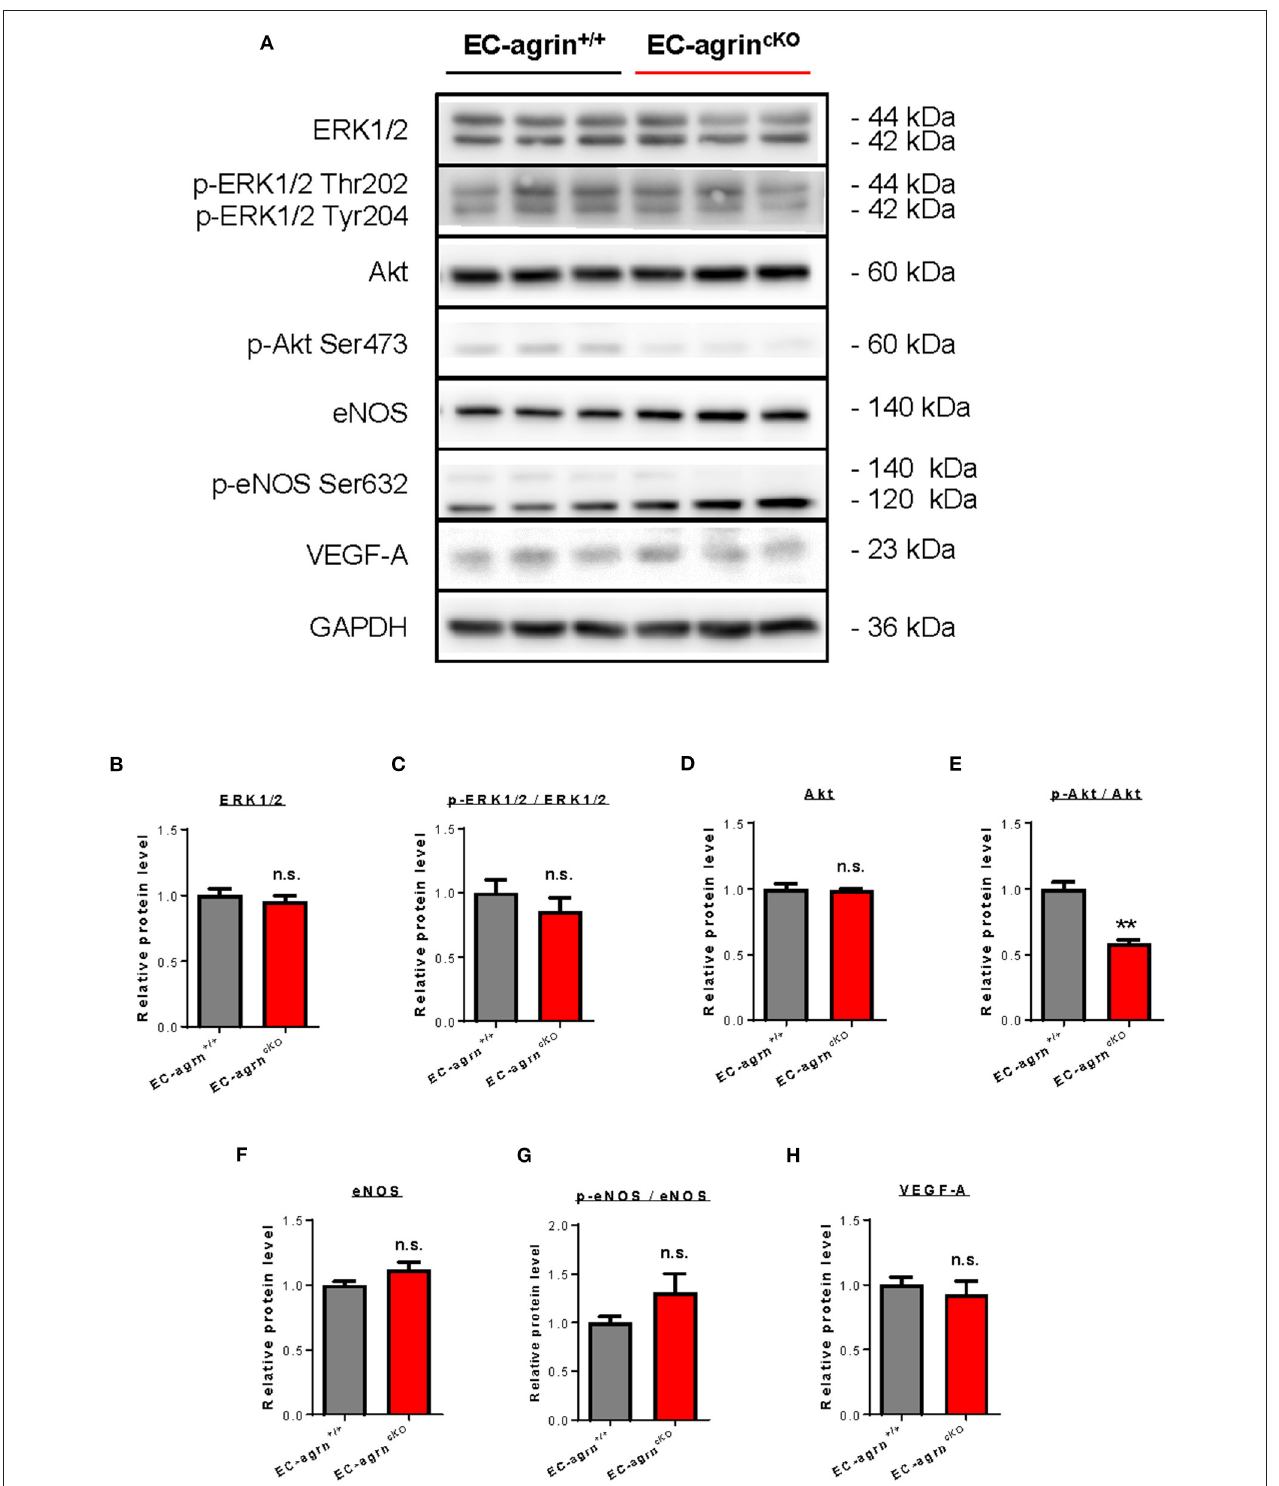
FIGURE 5 | Agrin does not regulate endothelial ERK1/2 mediated activation in vivo. (A) Western blotting analysis showing no significant difference in endothelial expression and activation of ERK1/2 or eNOS after endothelial loss of agrin in vivo . The expression and activation levels of (B,C) ERK1/2, (D,E) Akt and (F,G) eNOS; as well as the expression levels of (H) VEGF-A were measured in the skeletal muscle ECs of 6–8 weeks old EC-agrn + / + and EC-agrn cKO mice, respectively. (B–H) Data are presented as mean ± S.E.M., n = 3, differences were determined by ANOVA and Turkey’s HSD post-hoc test, ** P < 0.01, n.s. denotes no significant difference.